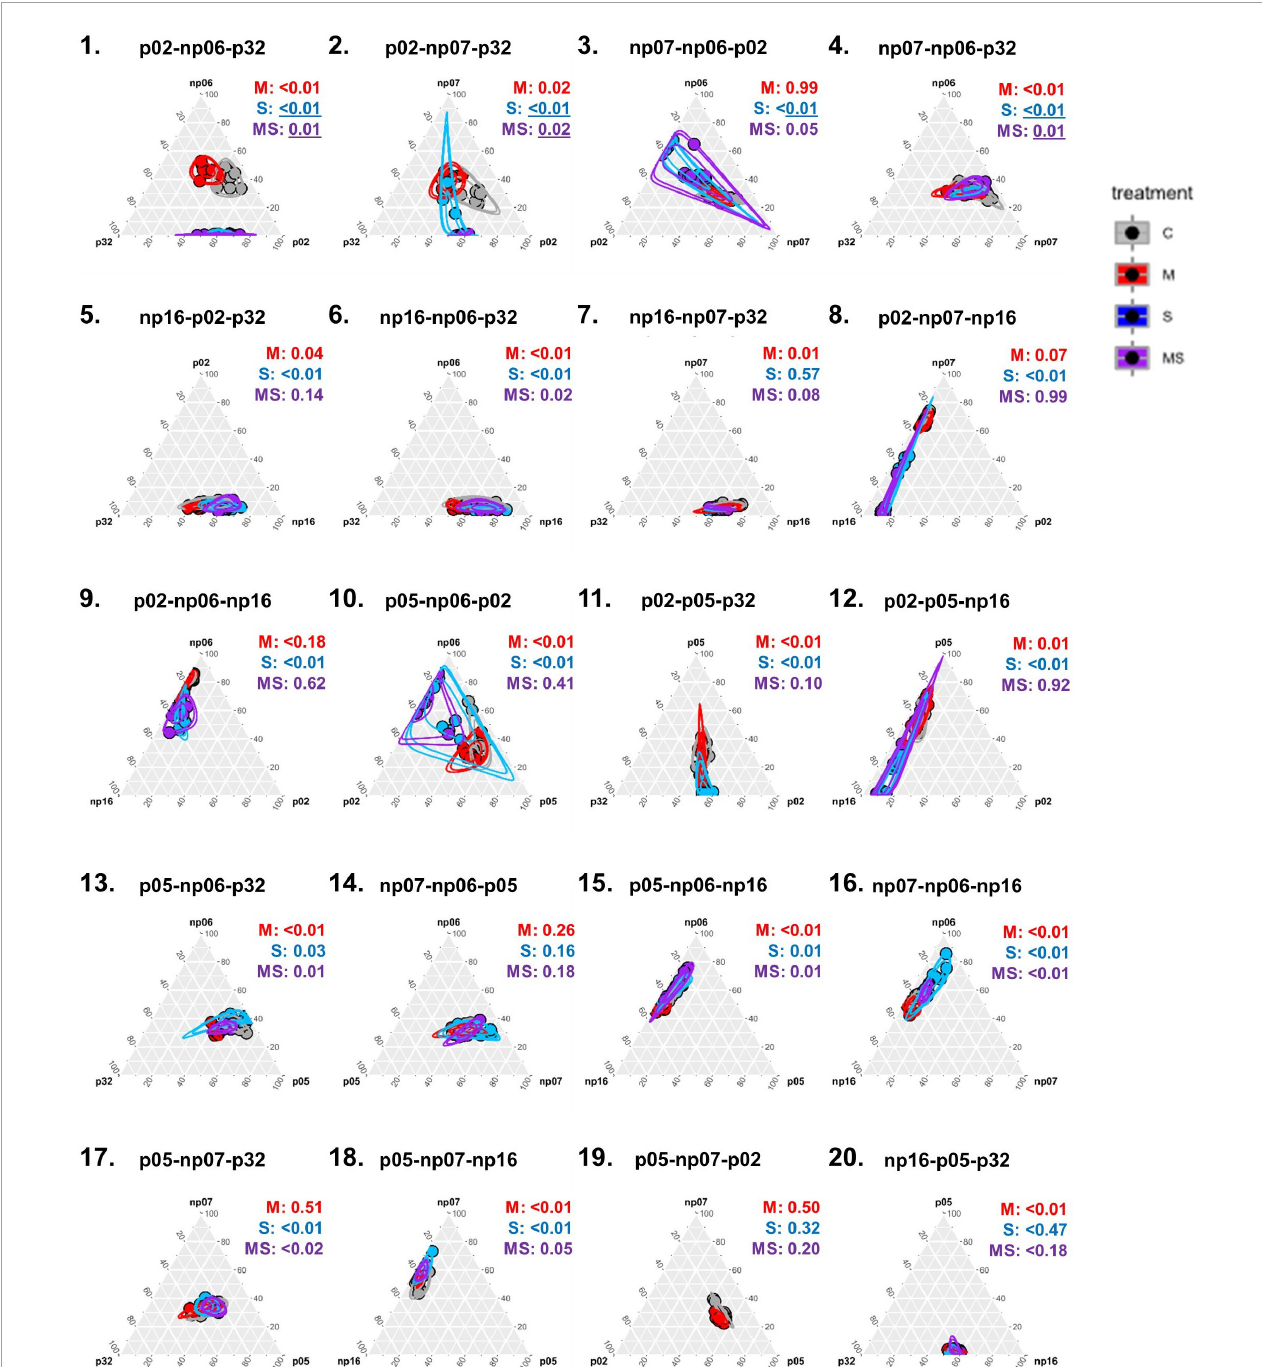
FIGURE4 Ternary plots depicting the effects of none (control, C), mild (M), strong (S), and both (MS) heat stress events on fungal isolates cultivated in triplets [ p -values from permutational multivariate analysis of variance (perMANOVA)]. Each dot represents one petri dish (one replicate for each treatment) and the circles are the 95% confidence intervals for each treatment. Values were scaled in the percentage of growth of each isolate in a triplet in relation to the maximum growth of that isolate in the full experiment (for information on actual growth rates of each isolate refer to Supplementary Figure 4 ).